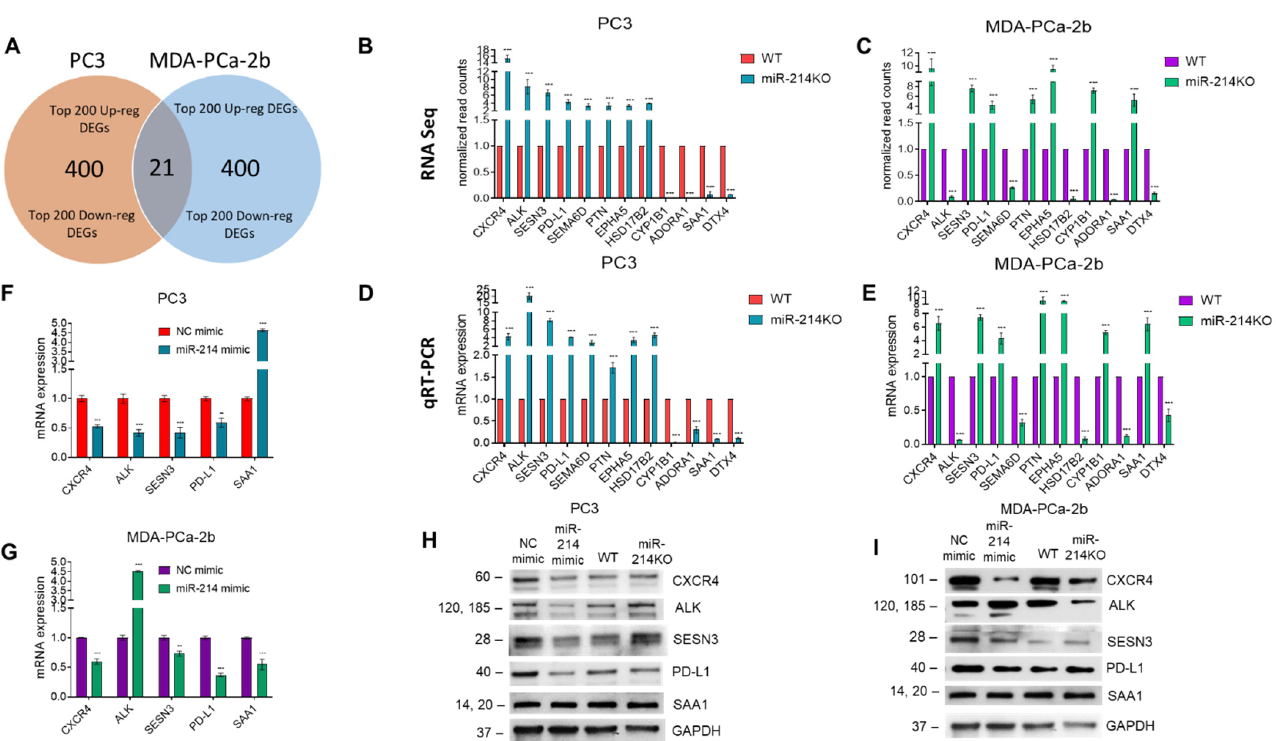
Figure 5. Modulation of overlapping target genes in miR-214-deleted PCa cells. ( A ) Venn diagram analysis of the top 400 aberrantly expressed mRNAs between WT and miR-214KO cells, as well as the overlapping genes between PC3 and MDA-PCa-2b groups. Normalized read counts of commonly regulated genes between PC3 ( B ) and MDA-PCa-2b ( C ) WT and miR-214KO groups. Relative expression levels of up/downregulated target genes were determined by qRT-PCR in PC3 ( D ) and MDA-PCa-2b ( E ) WT and miR-214KO cells. The mRNA ( F,G ) and protein expression ( H,I ) of CXCR4, ALK, SESN3, PD-L1, and SAA1 upon overexpression or knockdown of miR-214 was determined by qRT-PCR and Western blot analysis. Original blots see Supplementary File S5. Data are presented as mean ± SEM using two-way ANOVA with Šídák’s multiple comparisons test, ** p < 0.005, *** p < 0.0005.